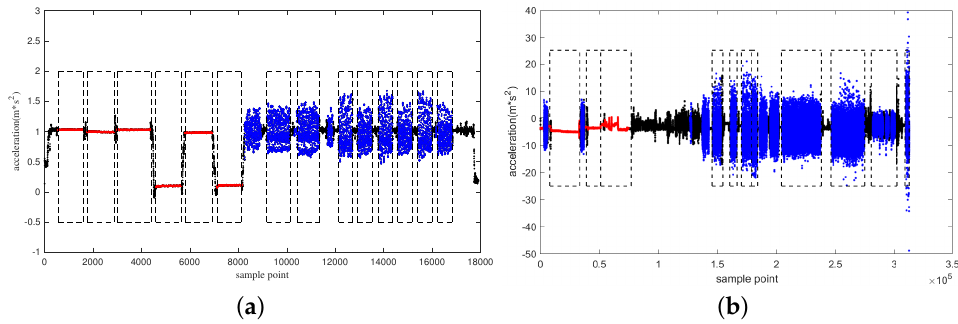
Figure 10. Segmentation results of the proposed scheme in different data sets, ( a ) UCI data set and ( b ) PAMAP2 data